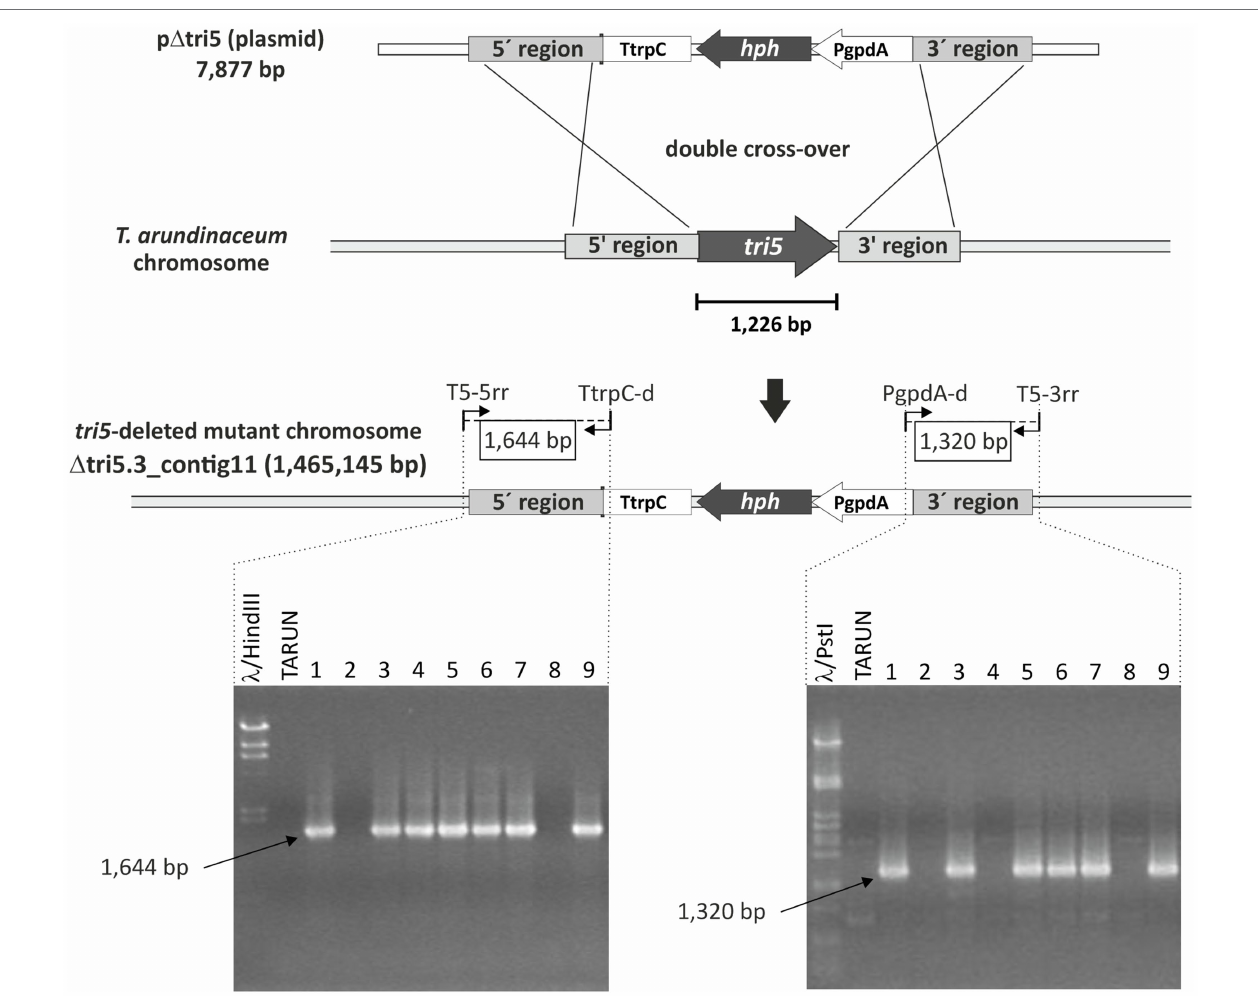
FIGURE 7 | Scheme of the strategy used to delete tri5 homolog in T. arundinaceum IBT 40837. Gel images below diagram of deletion strategy show PCR products amplified by the primers shown in the